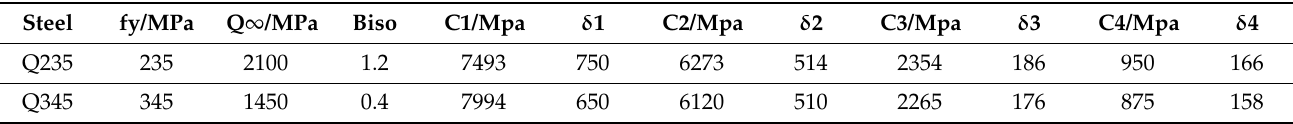
Table 4. Combined isotropic and kinematic hardening in